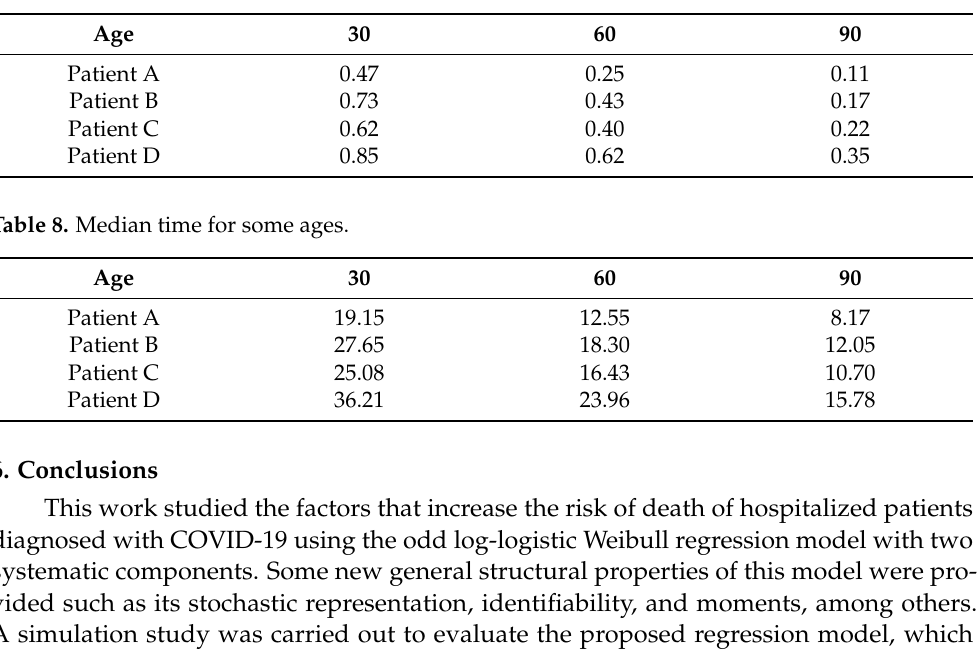
Table 7. Probability of hospitalized patients surviving 20 days after the first symptom.